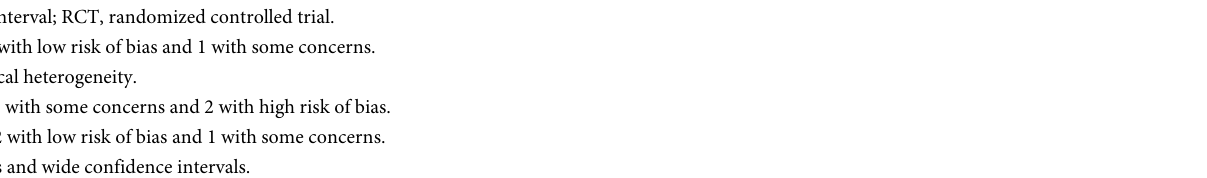
number of patients total